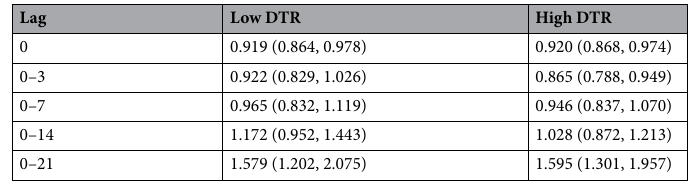
Table 2. The cumulative relative risks (CRR) of CVD hospital admissions in low and high DTR values. (1) Low DTR represents the 5th percentile of all study data, which was 3 °C. (2) High DTR represents the 95th percentile of all study data, which was 19 °C.